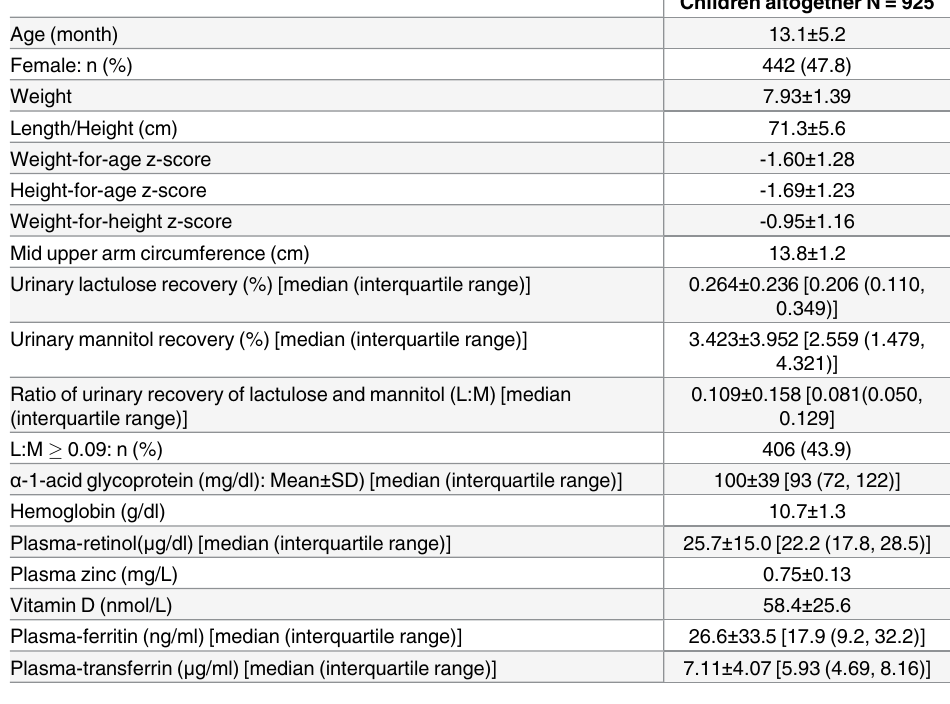
Table 1. Age, sex, anthropometric characteristics, lactulose and mannitol (L:M) test results and other biochemical values among the studied